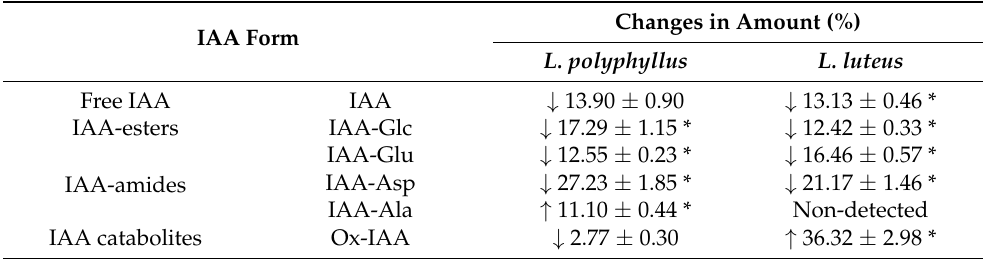
Values are mean ± SD of three experiments with five replicates in each. ↑ and ↓ —increase and decrease in content, respectively. *—significant difference ( p < 0.05) between mean values at 25 ◦ C and 30 ◦ C for each lupine species. Table 3. The comparison of IAA content in hypocotyls of four-day-old seedlings of two lupine species grown at 25 ◦ C versus 30 ◦